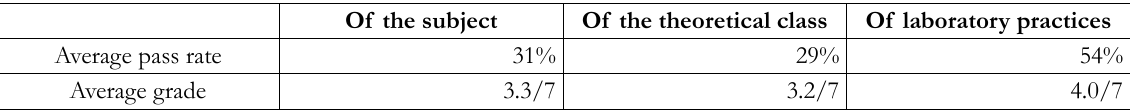
Table 1. Key average data on the starting situation of the theoretical-experimental